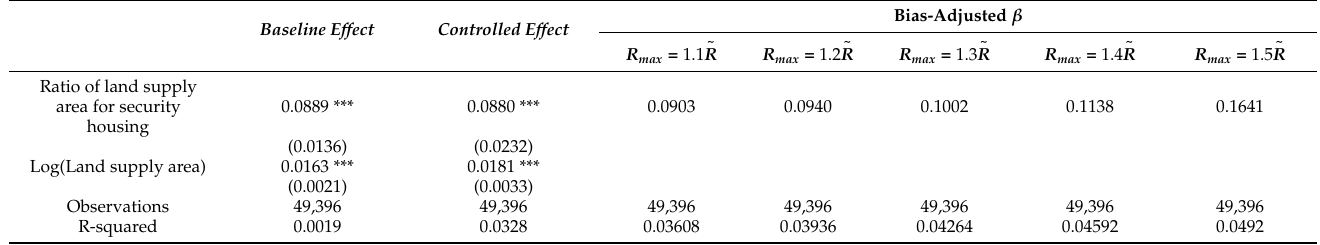
Table 5. Coefficient robustness to unobservable selection bias based on Oster